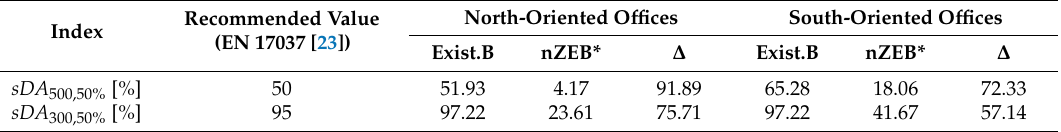
Table 7. Results of the daylight provision analysis for the existing building and the nZEB* building.